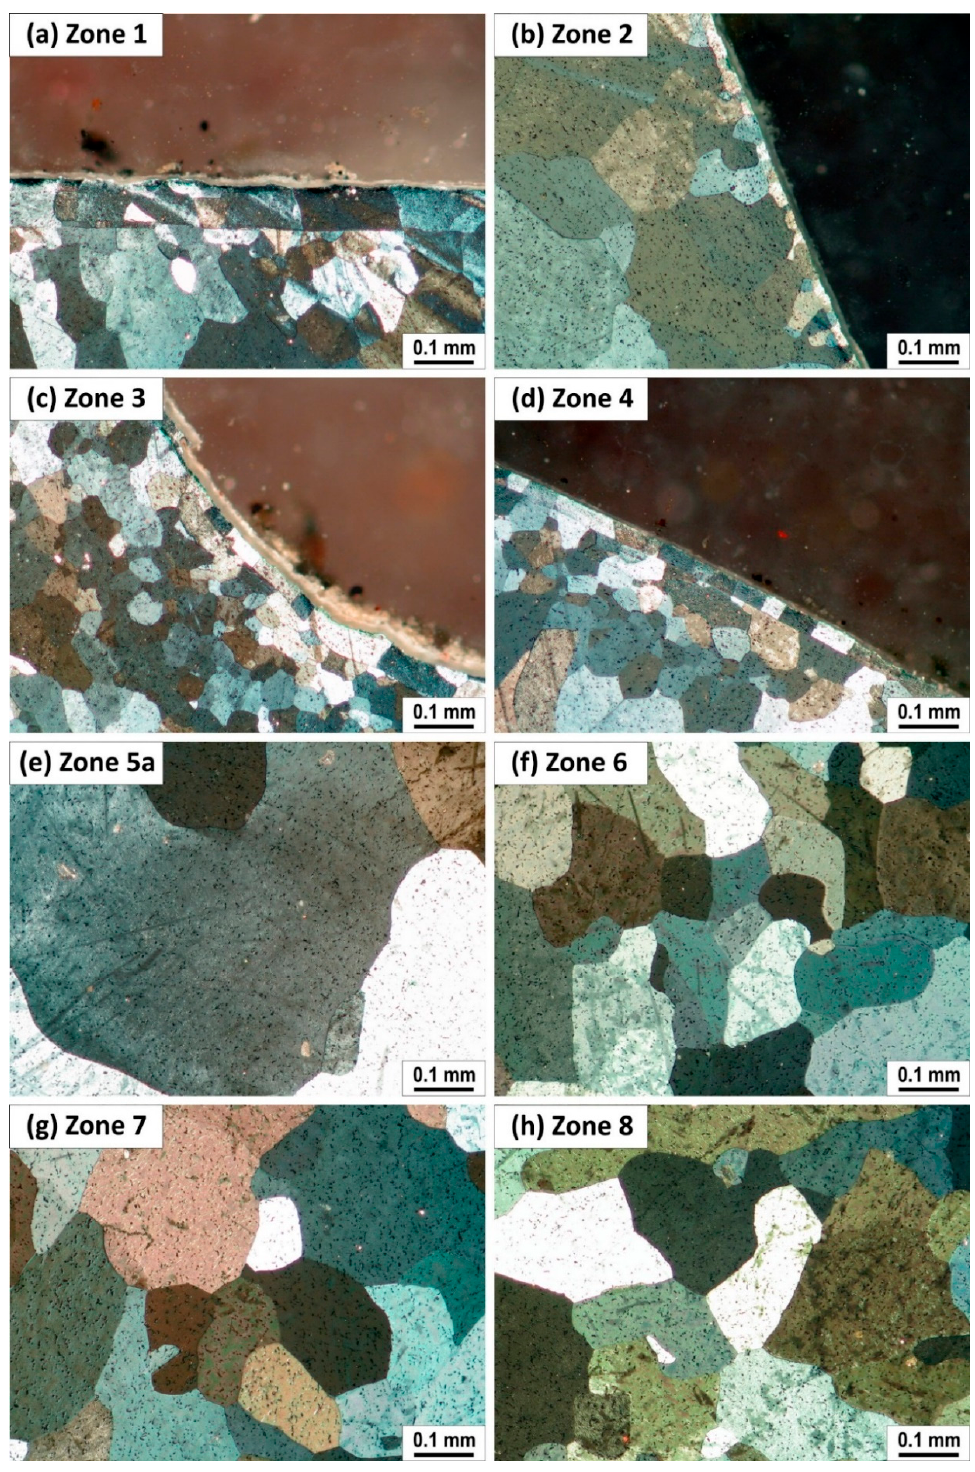
Figure 10. Grain size zones in the 30° segment of the gear-like element (polarized LM; the midpoint of Figure 10a–h is approximately indicated by arrows in Figure 8a): ( a ) zone 1 (top side of the tooth), d = 63 μ m; ( b ) zone 2 (the side of the tooth); d = 52 μ m; ( c ) zone 3 (the root of the tooth), d = 55 μ m; ( d ) zone 4 (the surface between the teeth), d = 59 μ m; ( e ) zone 5a (the center of the tooth), d = 399 μ m; ( f ) zone 6 (the middle between tooth roots), d = 152 μ m; ( g ) zone 7 (the intermediate zone between surface and center), d = 227 μ m; ( h ) zone 8 (the center of the gear-like element), d = 173 μ m.